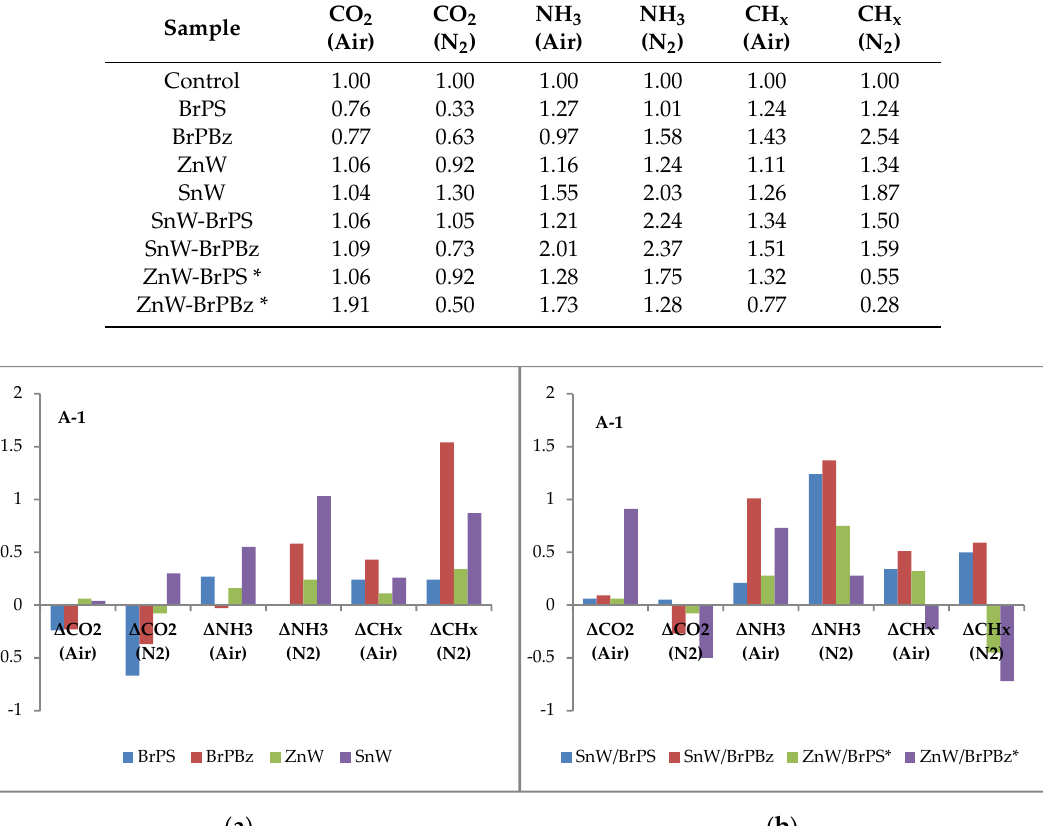
Table 3. TGA-FTIR gas / volatile absorption intensities (A) collected under air and N 2 , normalised to respective pure PA66 values (A = 1.00). The compositions of these samples correspond to those in Tables 1 and 2. Those samples marked with an asterix (*) have the best fire performance.